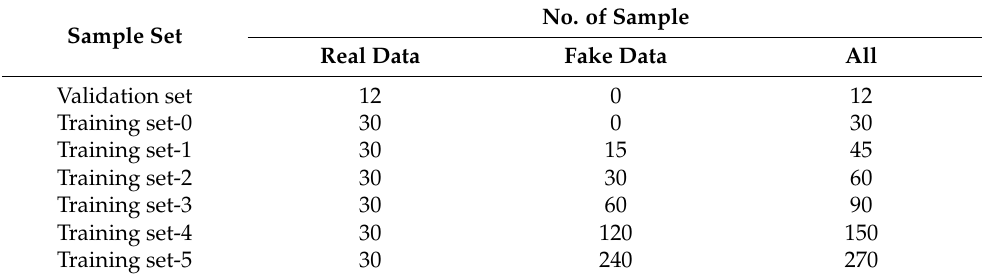
Table 1. Dataset partitioning